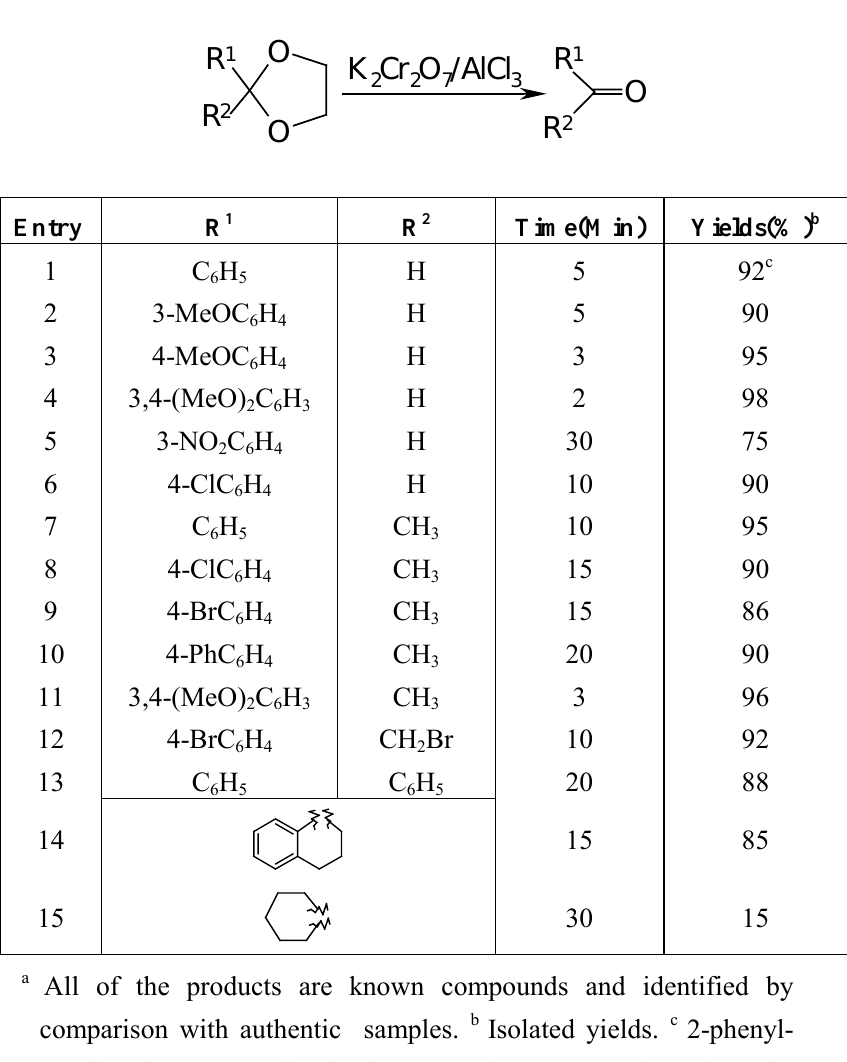
Table 5. Conversion of Ethylene Acetals and Ketals to Carbonyl Compounds